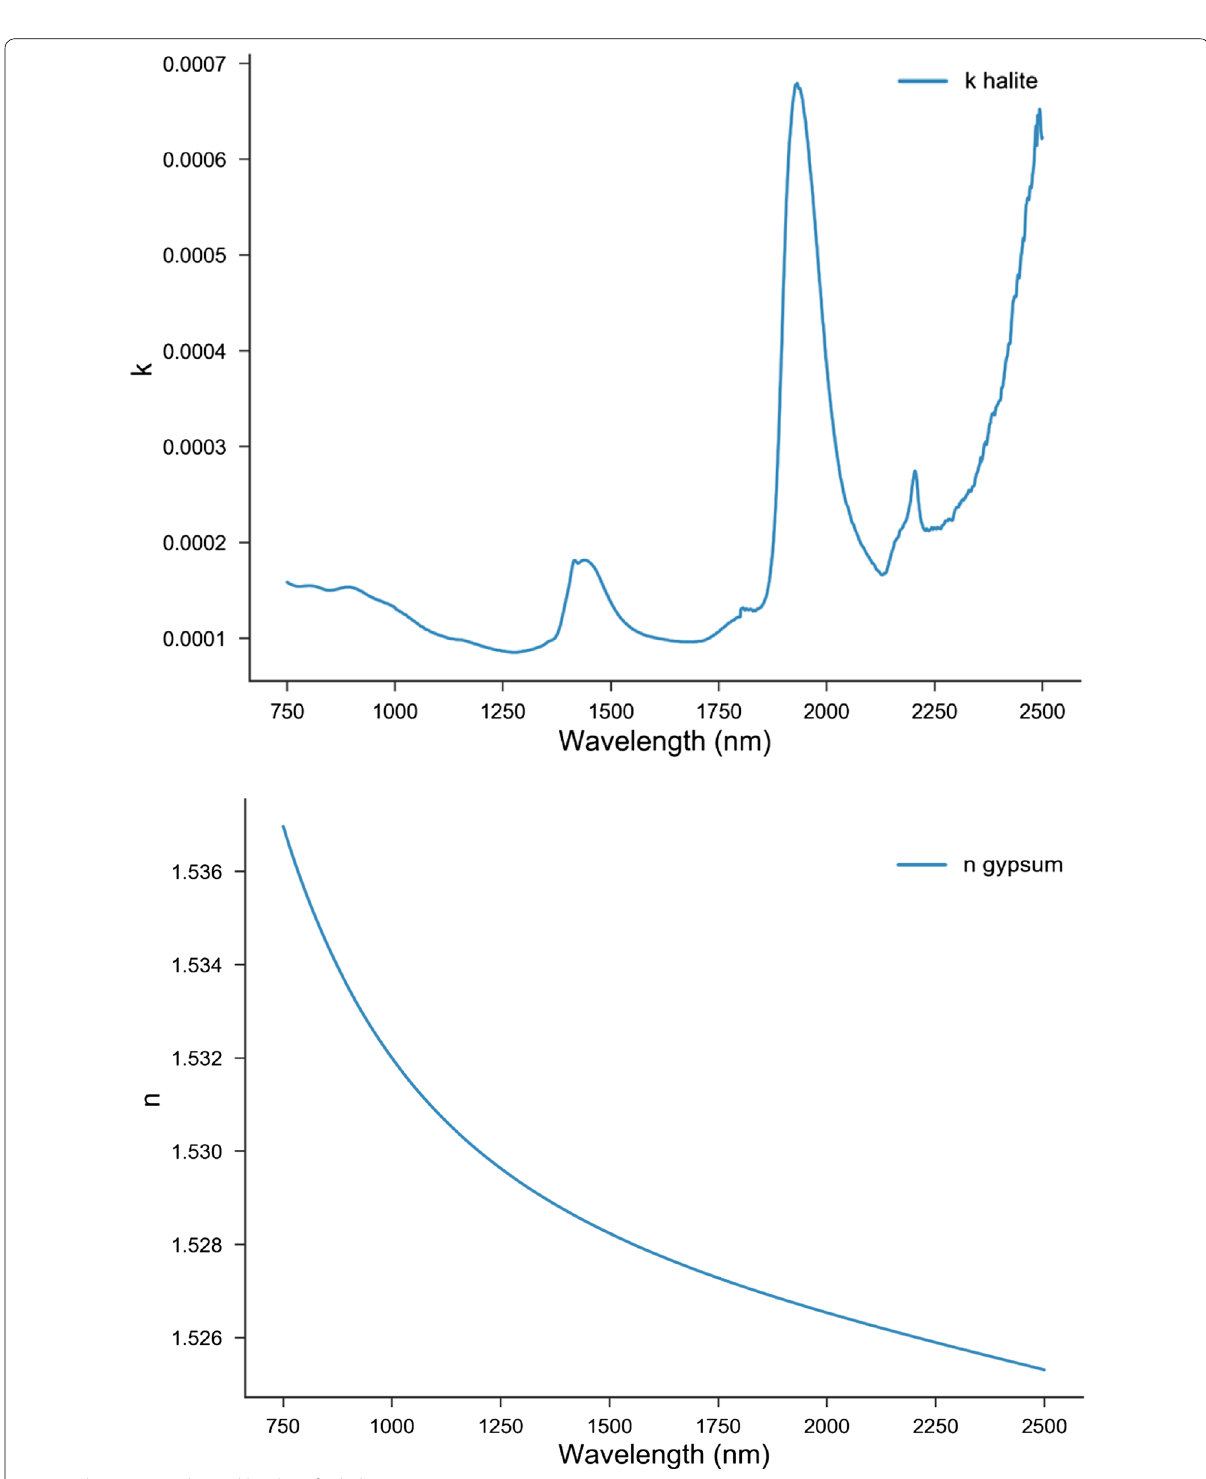
Fig. 7 The optimized n and k values for